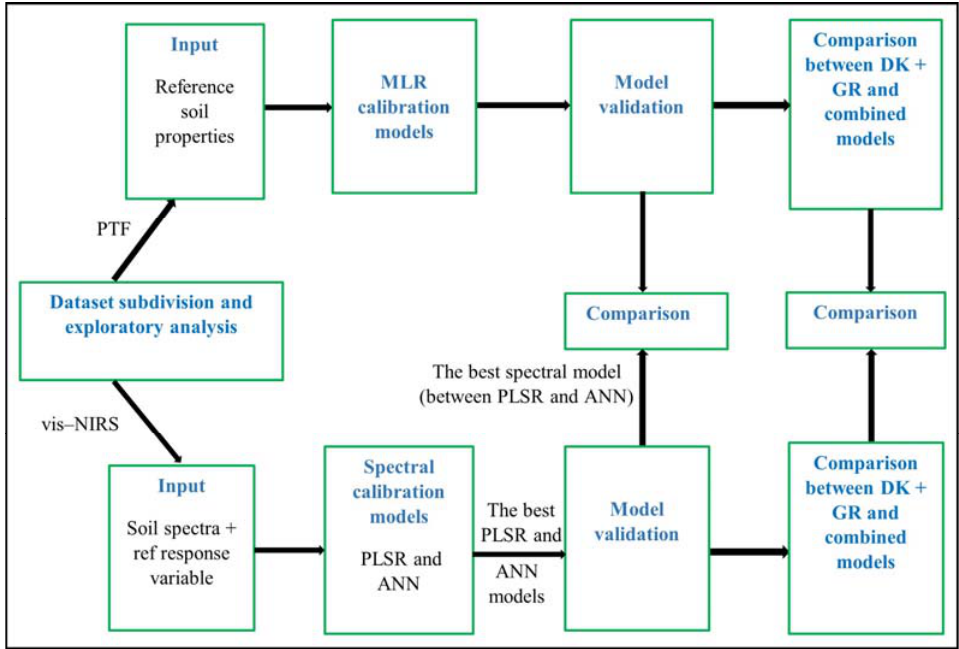
Figure 2. A graphical representation of the methodology for predicting the K d of glyphosate. vis– NIRS, visible near-infrared diffuse reflectance spectroscopy; PTF, pedotransfer function; MLR, mul- tiple linear regression; PLSR, partial least squares regression; ANN, artificial neural network; DK, Denmark; GR, Greenland.